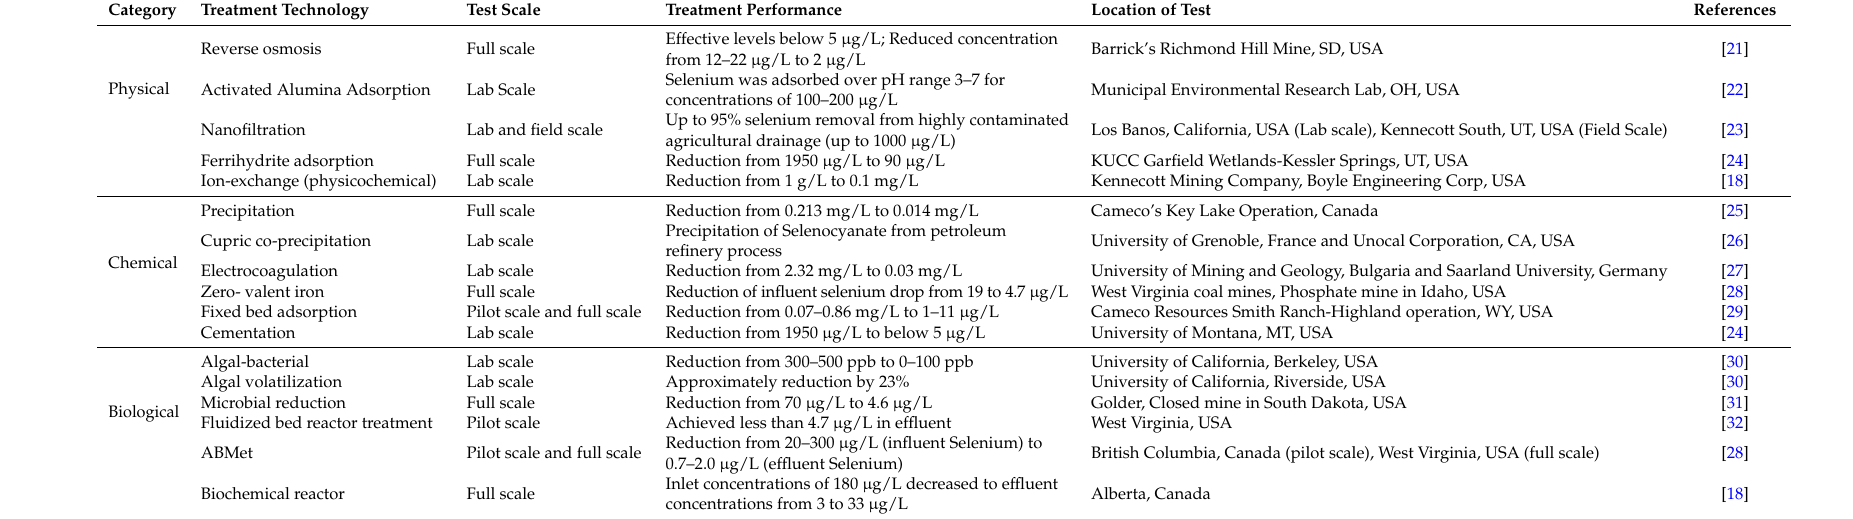
Table 3. Overview of selenium removal technologies reported in the